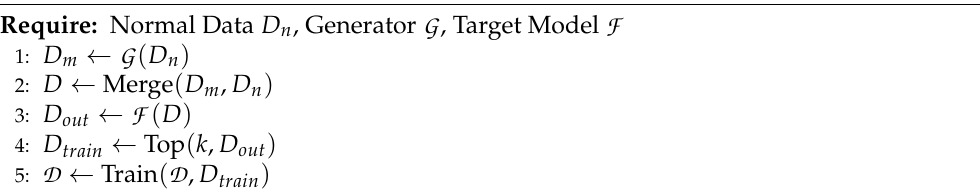
Algorithm 1 Detector Training Algorithm.